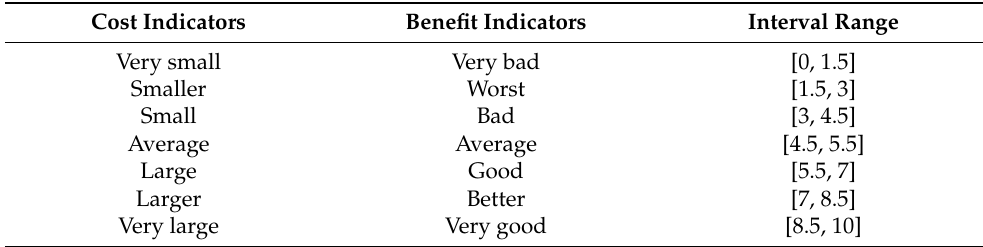
Table 2. Conversion rule between linguistic scales and interval